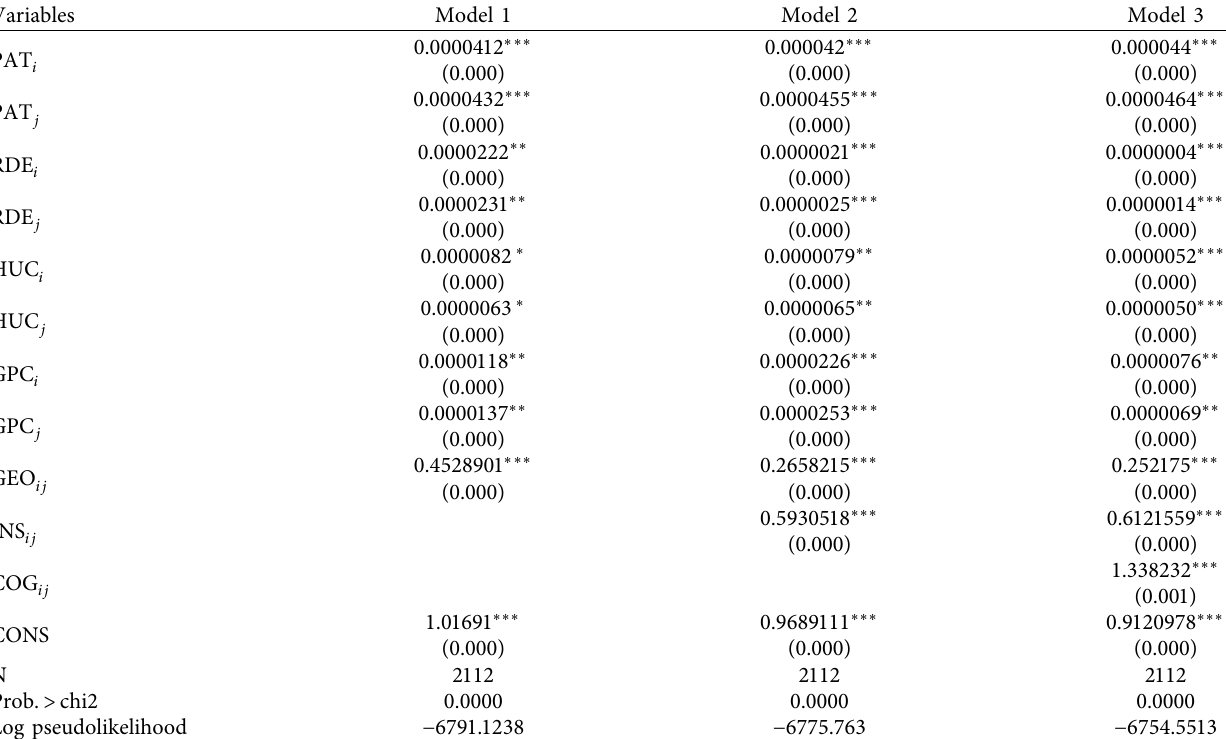
Table 4: Regression test results for impact of three proximities on intercity innovation networking.